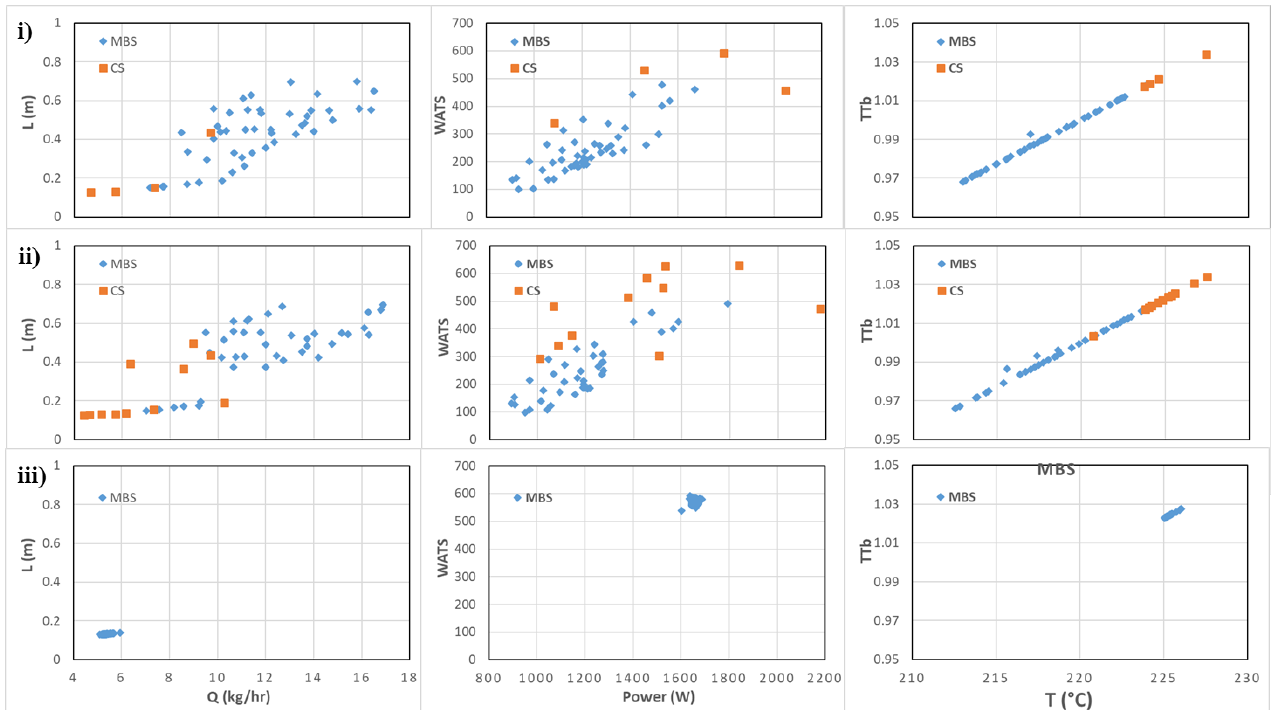
Figure 9. Pareto-optimal fronts after 100 generations for the pair of objectives identified in Figure 8 for Case 1. Table 7. Performance comparison using Hypervolume and IGD for the total number of objectives and the automatic reduction to four and three objectives (between brackets the standard deviation, and loss percentage relative to six objectives) for the four cases studied.